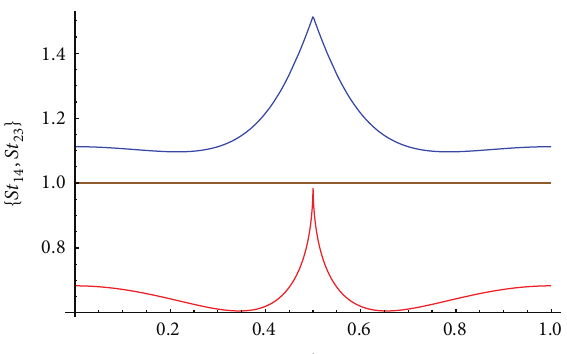
Figure 15: Stability function of the 2-cycle {𝑡 1 (𝛼),𝑡 4 (𝛼)} for 𝐶 1 and 𝐶